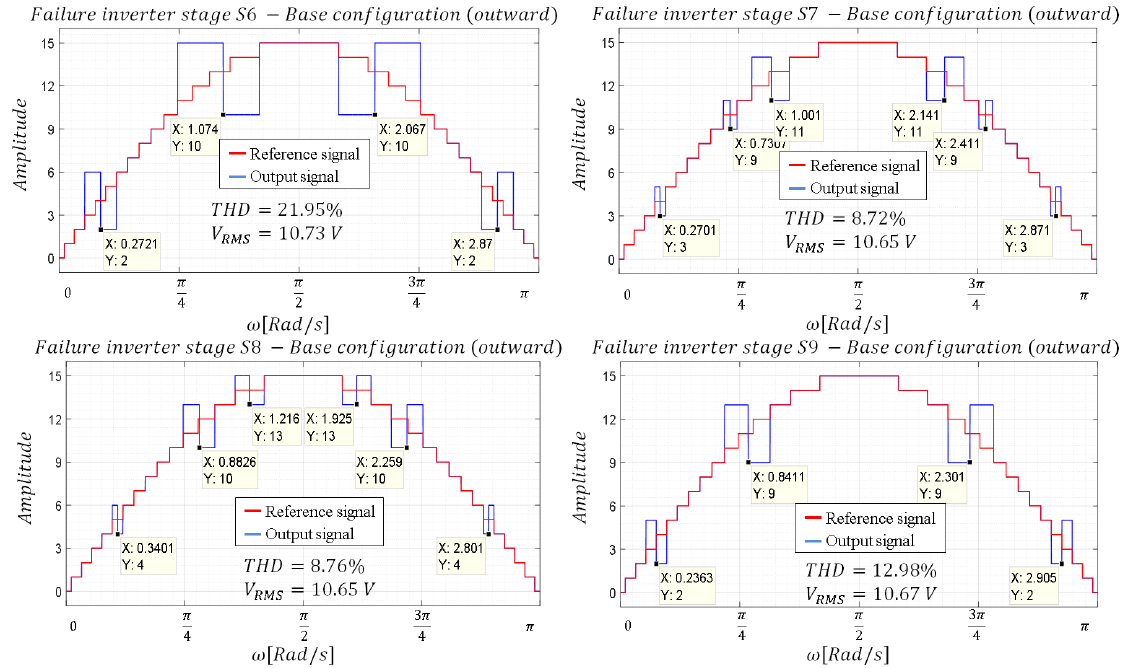
Figure 10. Waveforms—Base configuration with outward